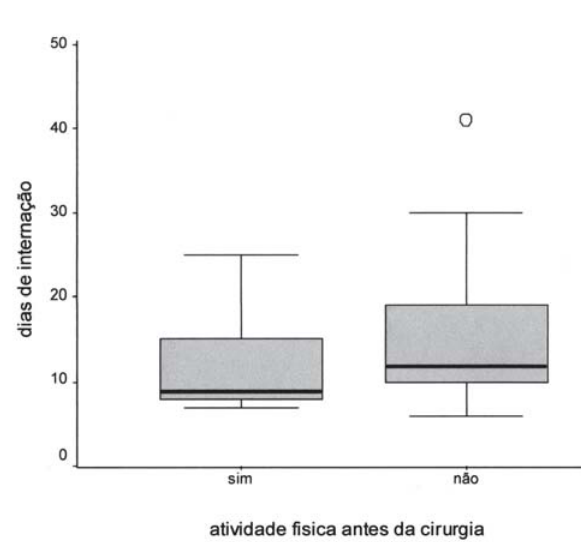
Fig. 1 - Tempo de internação em dias, após cirurgia de revascularização miocárdica, conforme prática de atividade física anterior ao procedimento cirúrgico. O tempo médio de internação foi de 15 ± 8 dias, no grupo de pacientes que não praticava atividade física e de 12 ± 5 dias, no grupo que praticava atividade física antes do evento cirúrgico. Houve diferença significativa (p<0,03) entre os grupos. A figura 1 apresenta a mediana do tempo de internação hospitalar no grupo que não praticava atividade física e no grupo que praticava atividade física, respectivamente 9 dias (8 - 15) e 12 dias (9 -